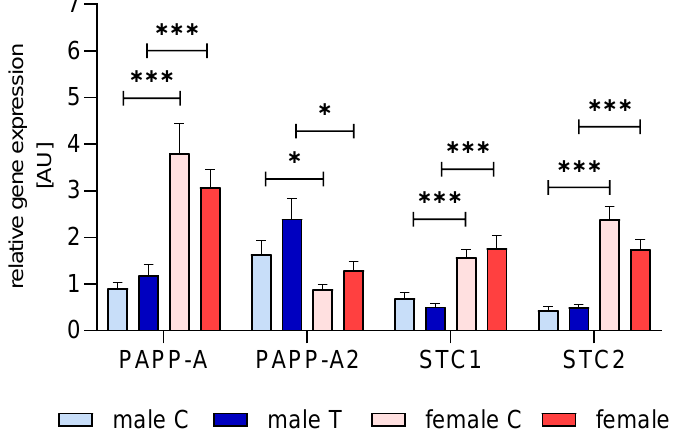
Figure 10. Gene expression of IGFBP-proteases (PAPP-A and PAPP-A2) and stanniocalcins (STC1 and STC2) in muscle from male (blue) and female (red) IGFBP-2 transgenic mice (T) and non-transgenic (C) littermates (DU6P / C57BL / 6). The mRNA levels were assessed by quantitative real-time PCR and normalized for the expression of housekeeping genes as described in Section 2 (mean ± SEM; age: 7 weeks; n = 10; *: p < 0.05; ***: p < 0.001).